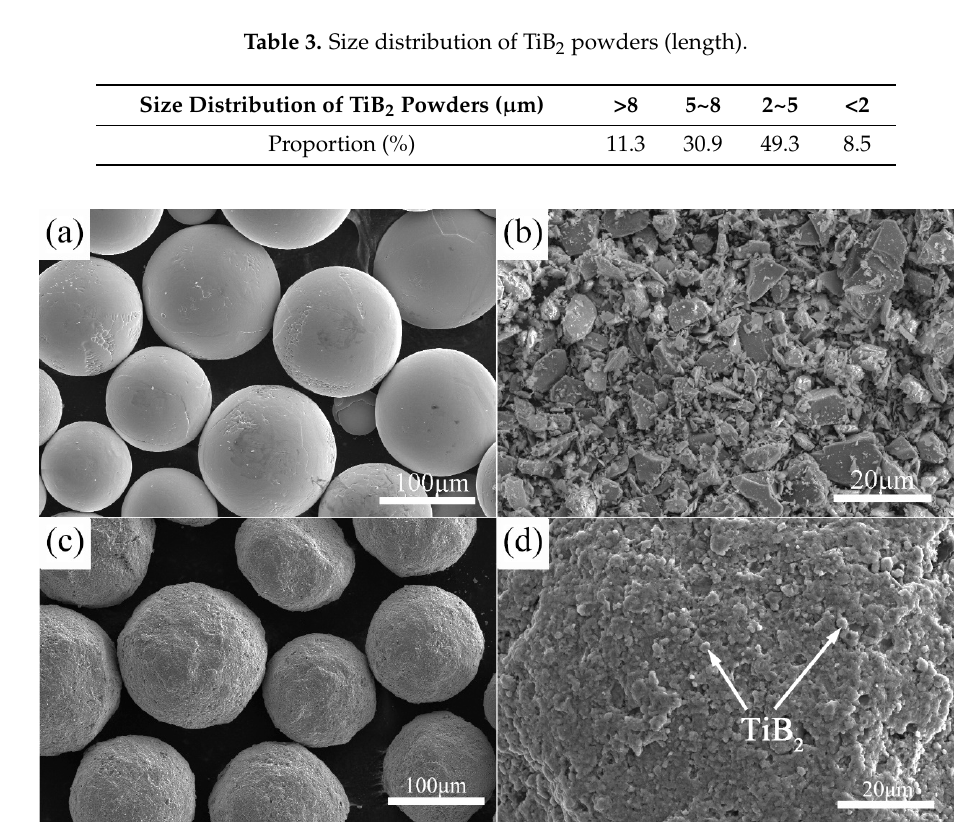
Figure 1. SEM micrographs of raw materials: ( a ) TA15 powders; ( b ) TiB 2 powders, lower-energy milled powders with low magnification ( c ); and high magnification ( d ); ( c , d ) show the mixed powders for fabricating 2.5 vol % TiBw/TA15 composite.